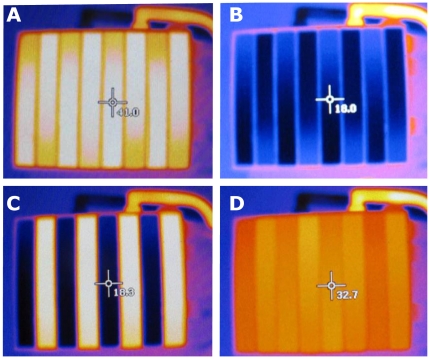
Thermography of the TGI-thermode surface.An infrared (IR) camera with high thermal resolution was used to verify the stimulus temperatures. Note that the temperature shown is that at the crosshair. Panel A) Warm-stimulus (41.0°C±0.5°C) Panel B) Cold-stimulus (18.0°C±0.5°C) Panel C)TGI-stimulus (41.0°C±0.5°C & 18.0°C±0.5°C). Note that the crosshair is centered on a cold plate . Panel D) Neutral baseline stimulus (31.0°C±2.0°C).